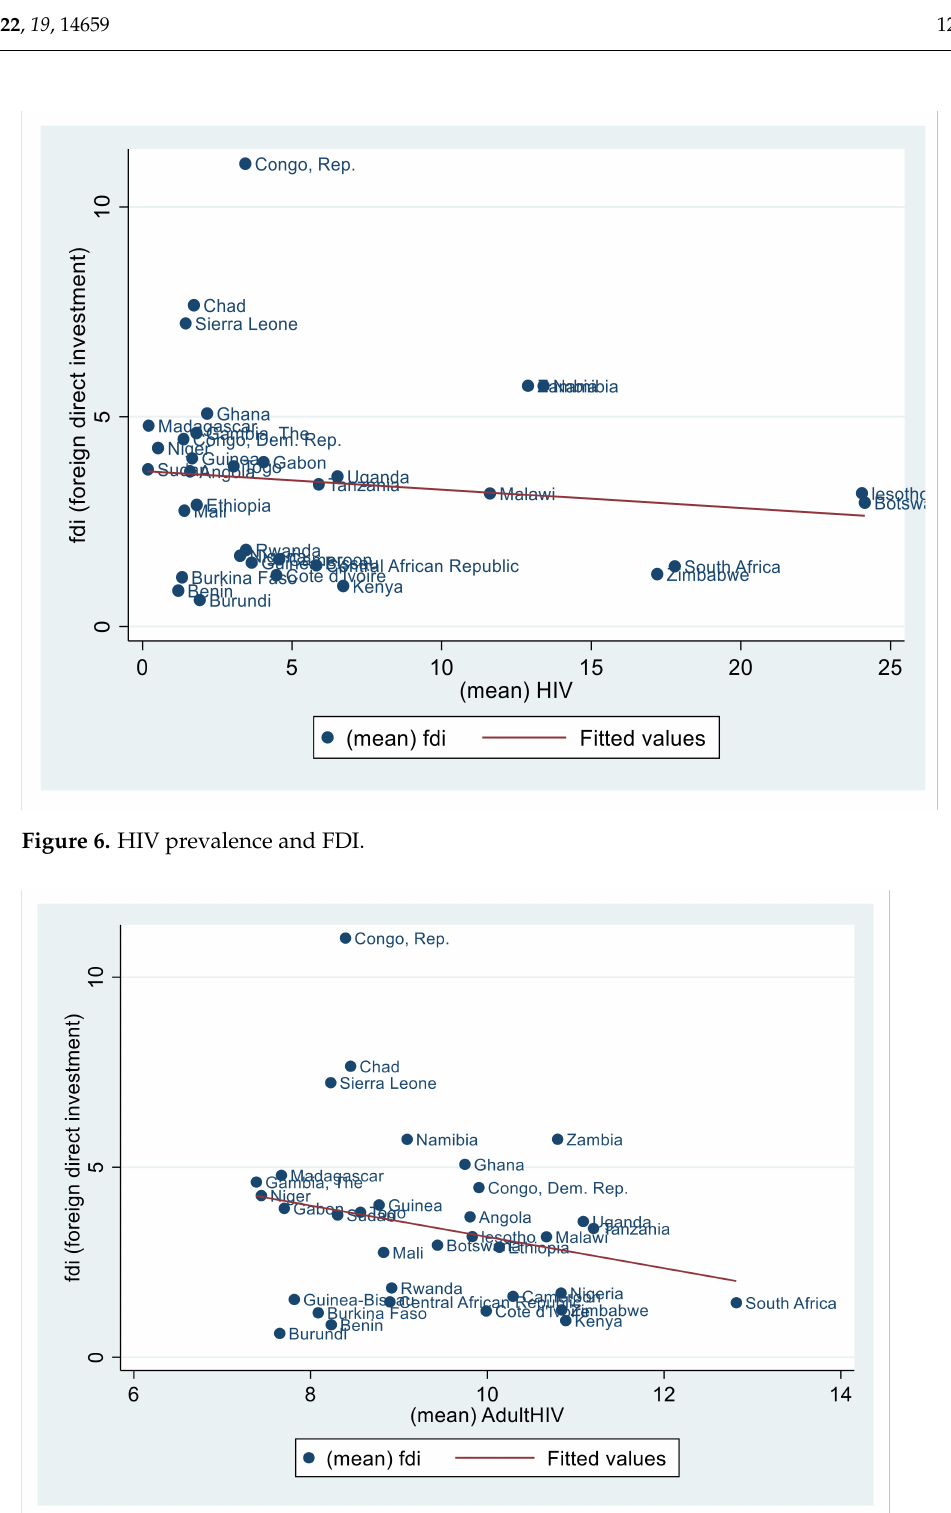
Figure 7. Adults newly infected with HIV and